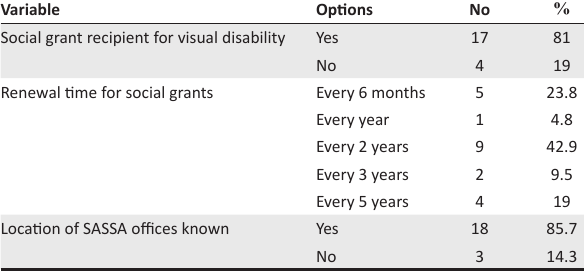
TABLE 4: Utilisation of social grants for visual disability.